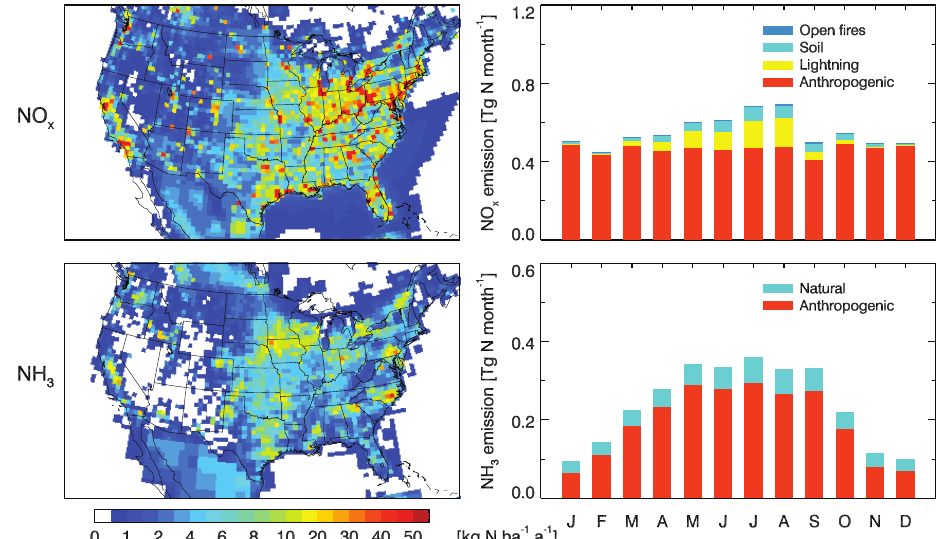
Fig. 1. NO x and NH 3 emissions in 2006-2008. The left panels show annual total emissions at the 1/2 ◦ × 2/3 ◦ resolution of GEOS-Chem. The right panels show seasonal variations for each source type over the contiguous US. Annual totals by source type are given in Table 2.